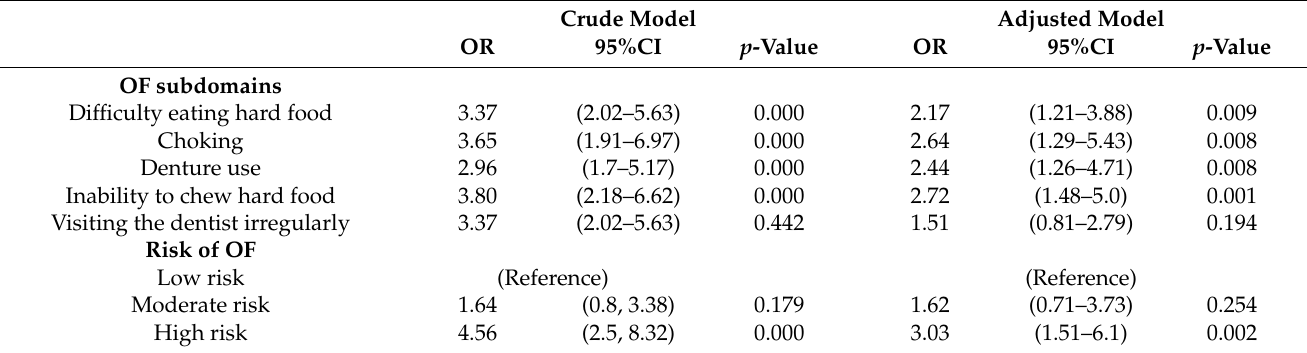
Table 3. Relationship among OF subdomains, risk of OF, and physical